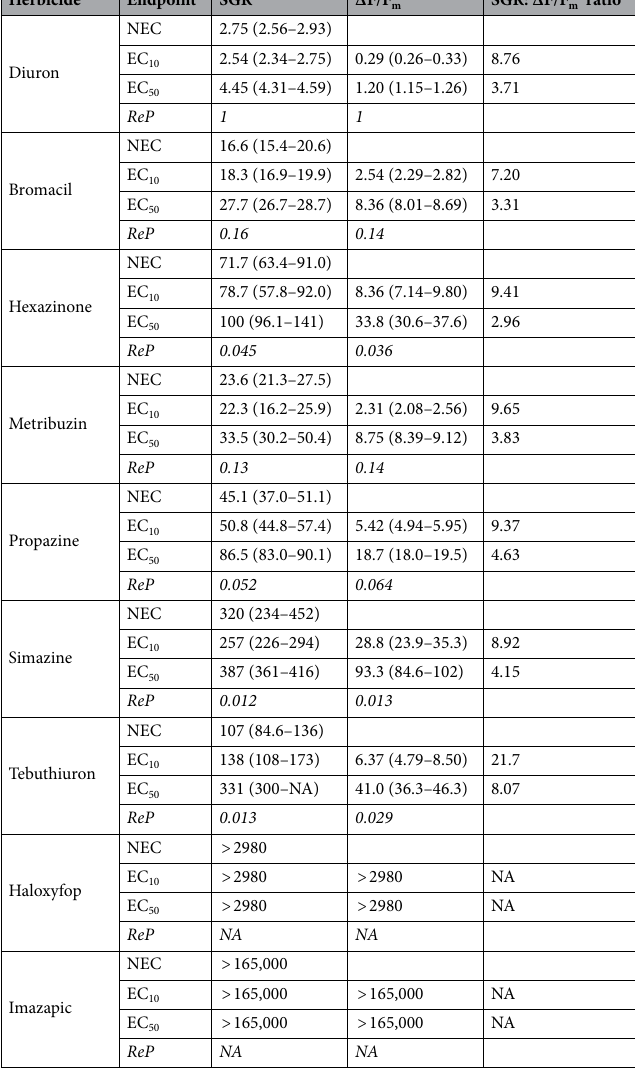
Table 2. No effect concentration values (NEC, Fig. 2) and effect concentration values (EC 10 and EC 50 , Fig. 1) for growth inhibition (SGR) and photoinhibition (ΔF/F m ′ ) of Cladocopium goreaui over 14 days to each herbicide. Concentrations are reported in µg L −1 (95% confidence intervals). Relative equivalent potencies ( ReP) of each herbicide are derived by comparing SGR EC 50 of each herbicide to the reference herbicide diuron. Calculated ReP values in italics to differentiate from modelled no effect and effect concentration values. NA denotes data not